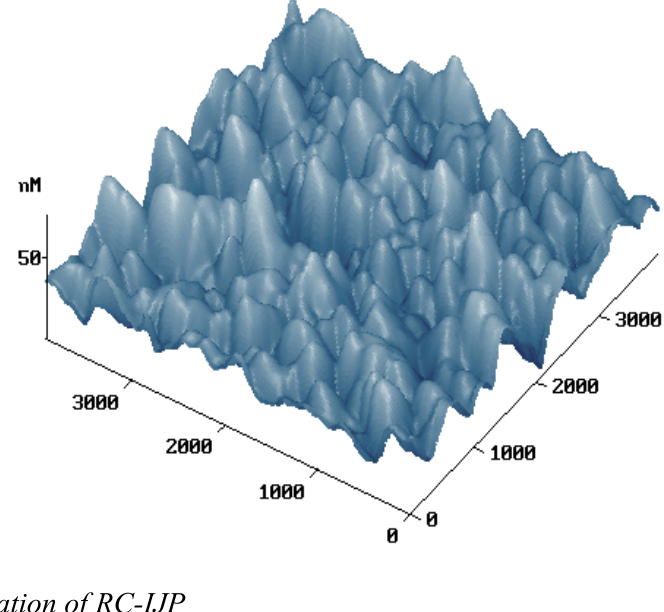
Figure 4. Atomic force microscope (AFM) image of RC-IJP.